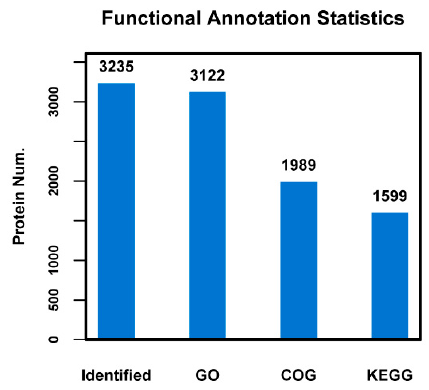
Figure 2. Statistical results of different functional annotations. The x -axis indicates identified or different annotation databases, and y -axis indicates protein number .